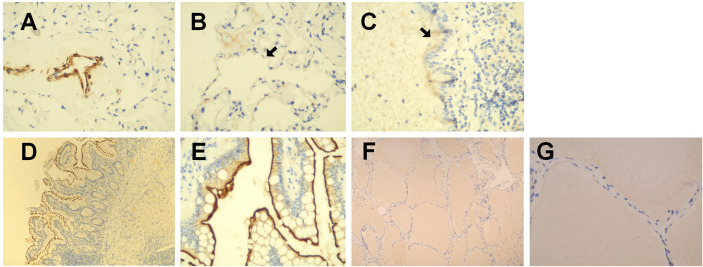
Immunohistochemical staining of ACE2 in human healthy lung tissues. small intestines and thyroid tissues. (A–C) in healthy lung tissue sections, ACE2 was widely expressed in pulmonary vascular endothelial cells, alveolar epithelial cells, bronchial mucosal epithelial cells, and on the apical surface of ciliated columnar epithelial cells. (D, E) in human normal small intestine sections, ACE2 was mainly expressed on the surface of villi epithelial cells. (F, G) ACE2 immunoreactivity was not observed in human normal thyroid tissue sections. Original magnification: (A–C, E, G): ×400; D&F:×100.